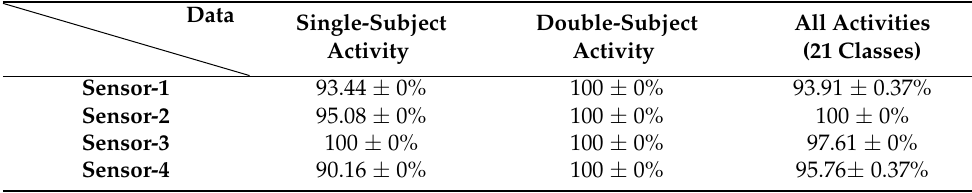
Table 4. Testing performance of the classification models using SVD with LR classifier for different number of activities of Infra-ADL2018